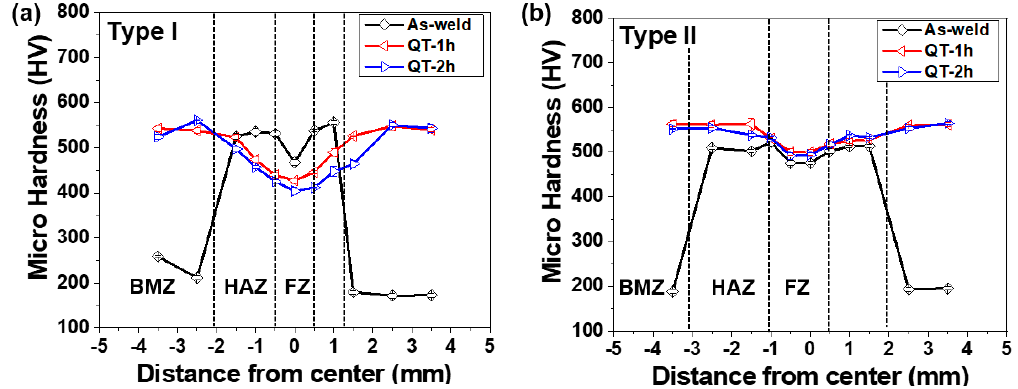
Figure 9. Microhardness distribution along with the mid-thickness layer of the weld joints: ( a ) Type-I and ( b ) Type-II.